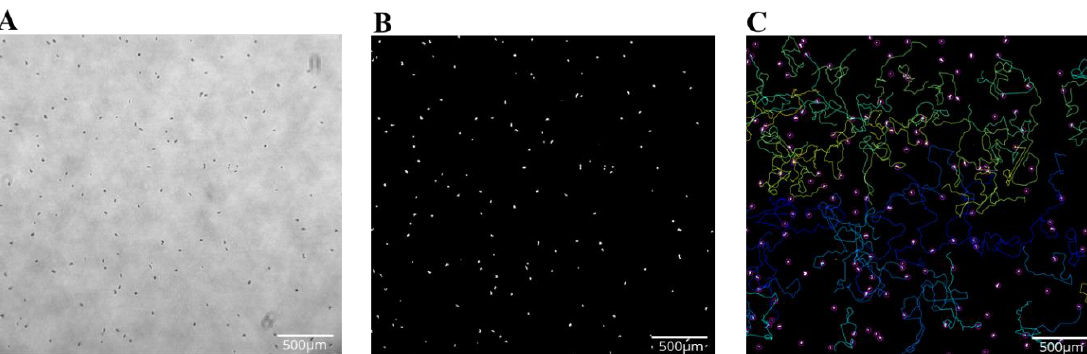
Figure 2. Representative images of the track analysis process . ( A ) Bright-field microscope image taken in original grayscale. ( B ) Same image converted to binary, where Acanthamoebae appear as white organisms on a black background. ( C ) Same image with selected tracks shown (not all tracks present), where ImageJ has assigned a unique color for each individual track. Magnification = 4×, scale bar = 500 um.